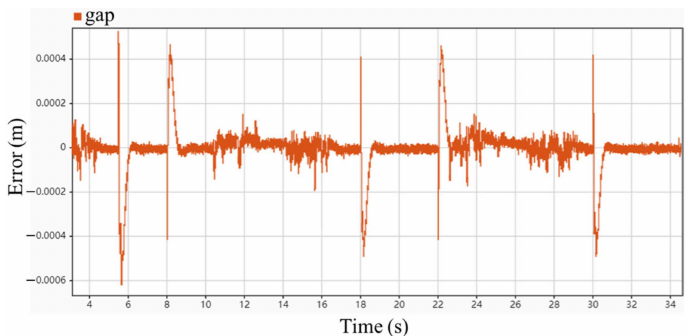
Figure 16. Suspension clearance curve of step response output of closed-loop suspension system experiment based on PID algorithm without feedforward filter link.